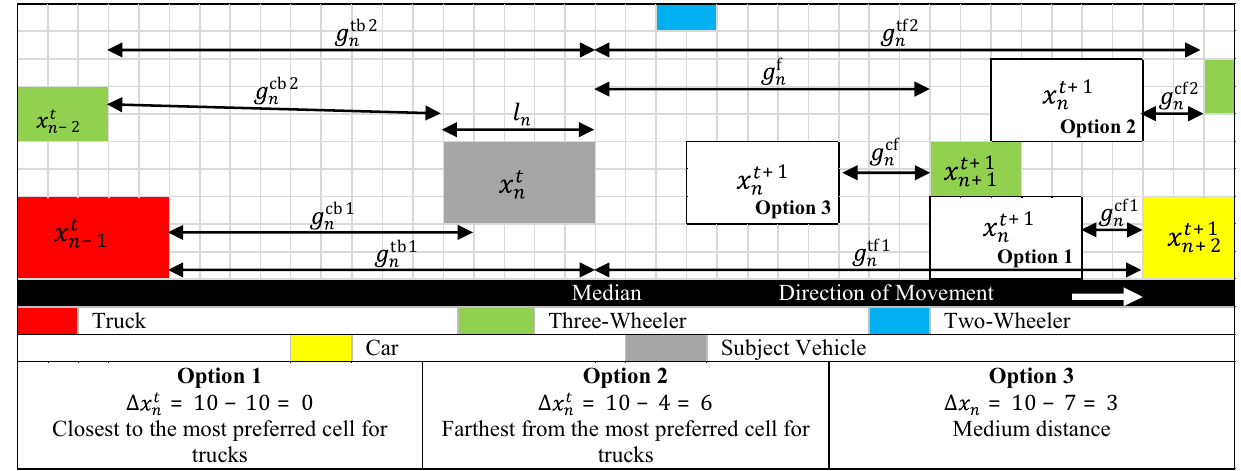
Fig. 1 CA lattice structure and relative positioning of